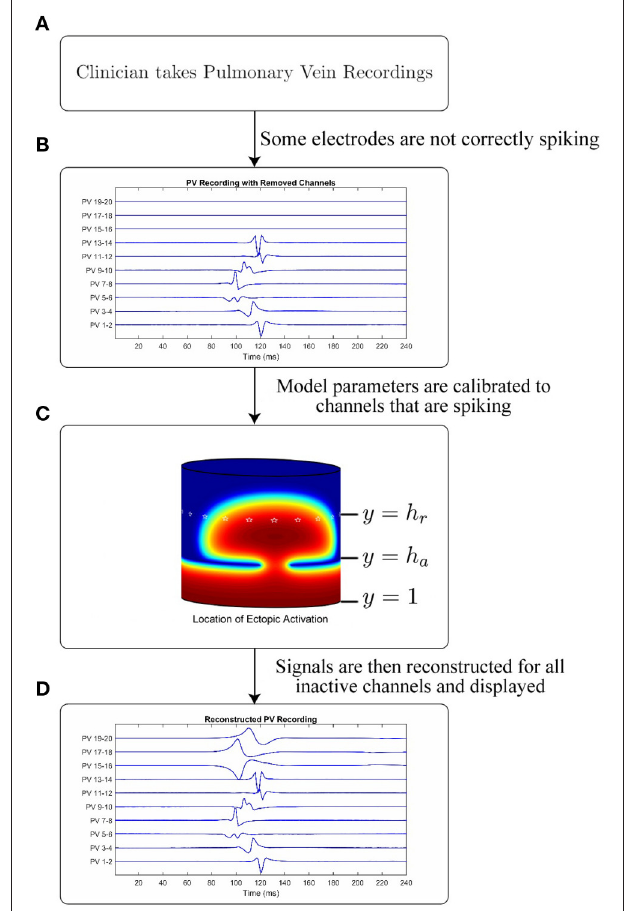
FIGURE 2 | Schematic and application of model. Figure showing the intended application of the model. (A) A cardiologist records Pulmonary Vein Recordings using a lasso catheter. (B) An example of a pulmonary vein recording with some channels not correctly spiking (missing channels). (C) A model simulation demonstrating the propagation through a conduction gap, showing high intracellular potential in red and low in blue. White stars are plotted on the electrode locations. (D) The result of applying the model to the signal in B to recover the lost channels.